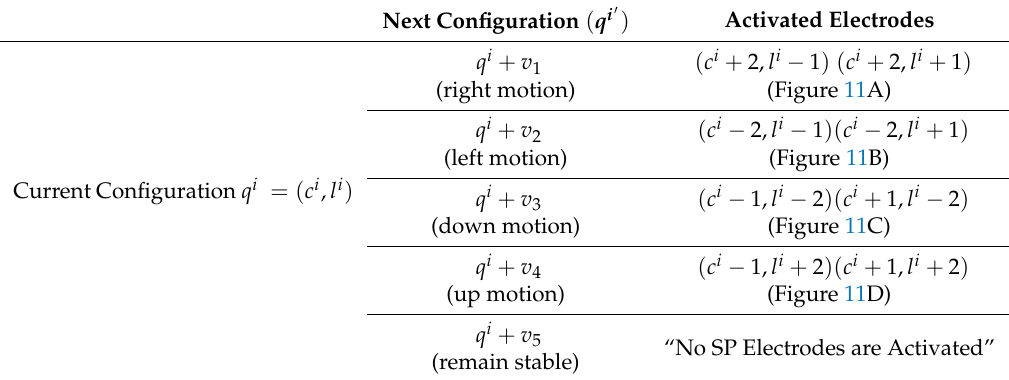
Table 2. Activation Methods of the “Smart Platform” (SP) electrodes for the right/left and down/up motion of the microparts.